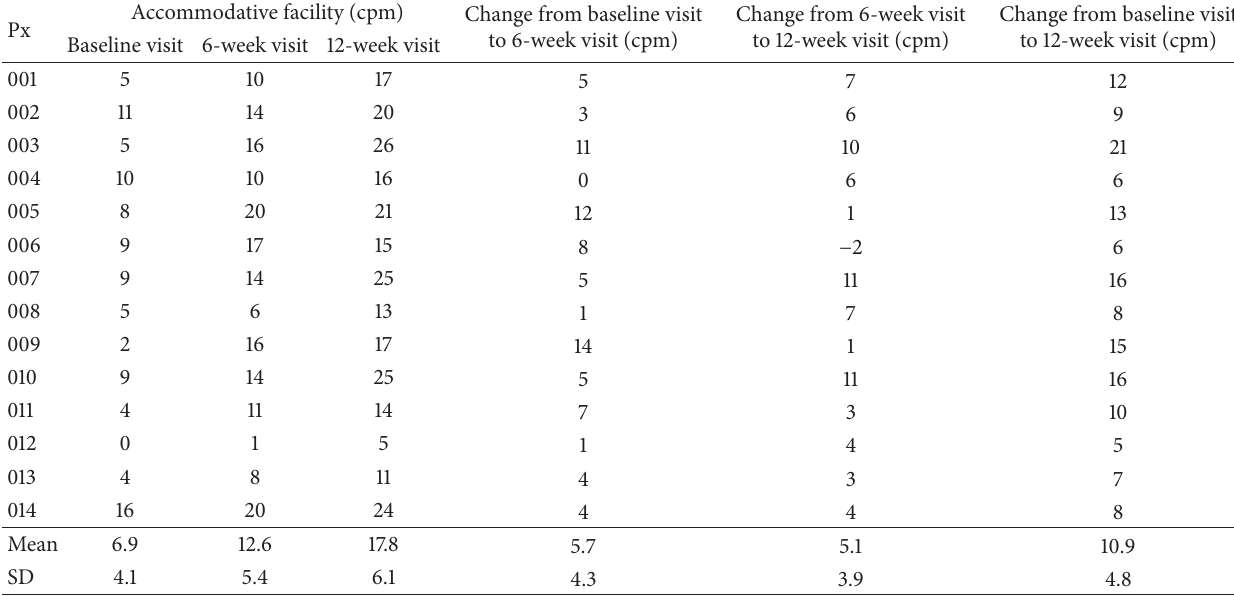
Table 4: Result and comparison of monocular accommodative facilities at different